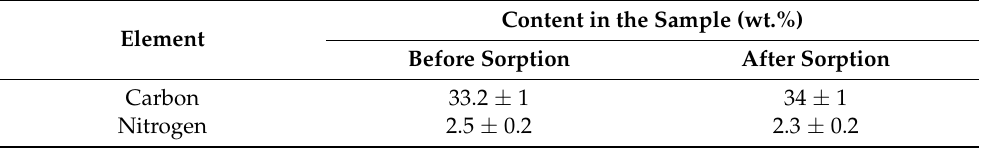
Table 5. Carbon and nitrogen contents (in percent by mass) of the hybrid hexadecylamine-vanadium oxide, VO x -C16, material loaded with the maximum quantity of cesium before and after sorption from aqueous CsNO 3 solutions. Content in the Sample (wt.%) Element Before Sorption After